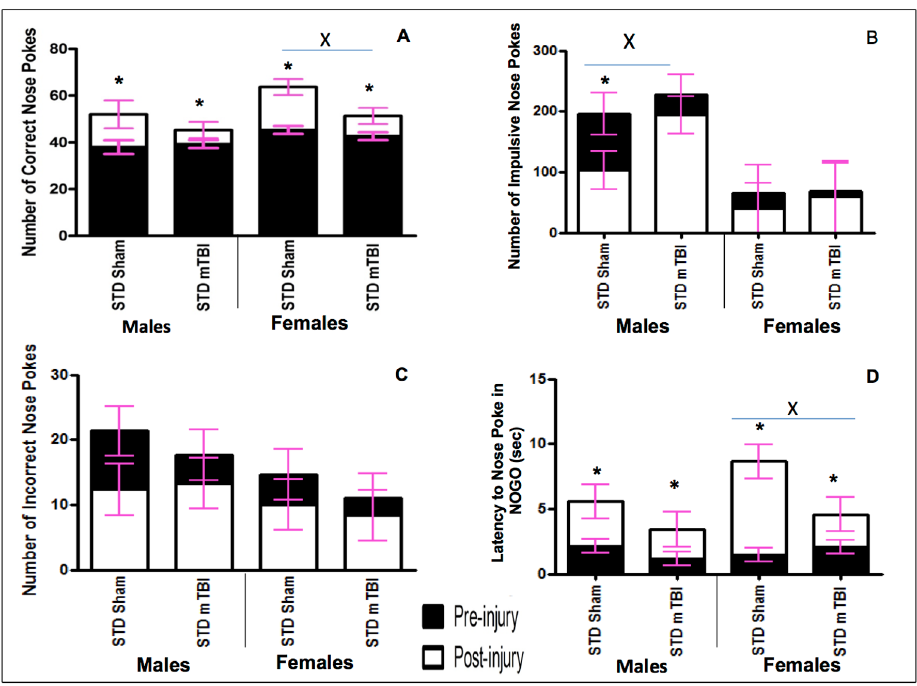
Fig 2. Graphical representation of Go/No-Go results. A) Accuracy, B) Impulsivity, C) Inaccuracy, and D) Response Inhibition, for male and female animals from the STD cohorts at the pre-injury (black bars) and post-injury (white bars) test sessions (x significant effect of mTBI, * significant effect of testing period, all p < .05).